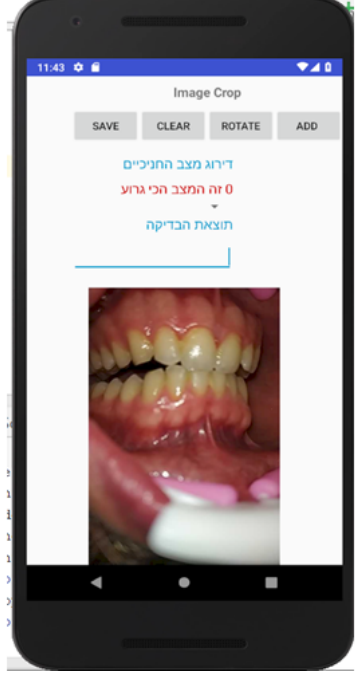
Figure 21. Viewing screen for the dentist: the dentist can view the dental selfie and rate the patient's